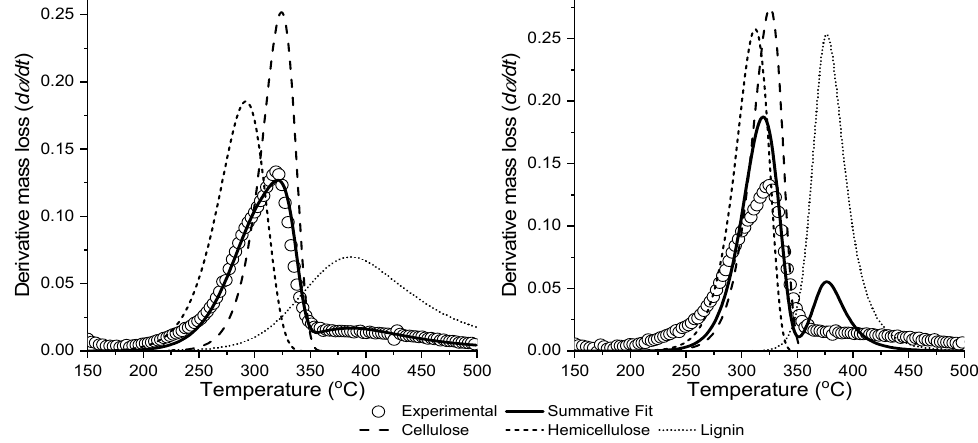
Figure 6. Comparison of the curve-fitting n 3 = 3 method ( left ) and the isoconversional KAS (n 3 = 3) method ( right ). Experimental data: DTG from WS-P, 10 K·min − 1 .